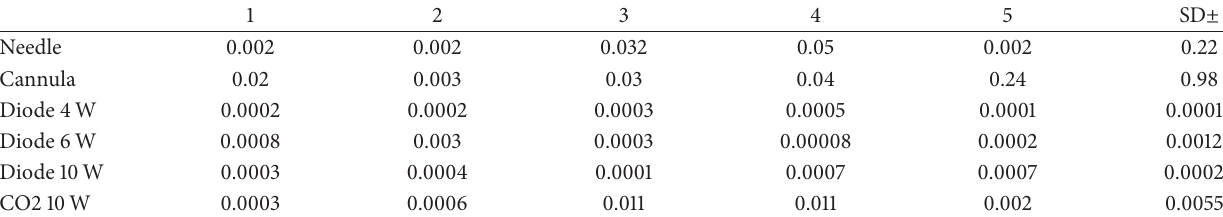
Table 2: Pressure gain velocity in mmHg/msec (five